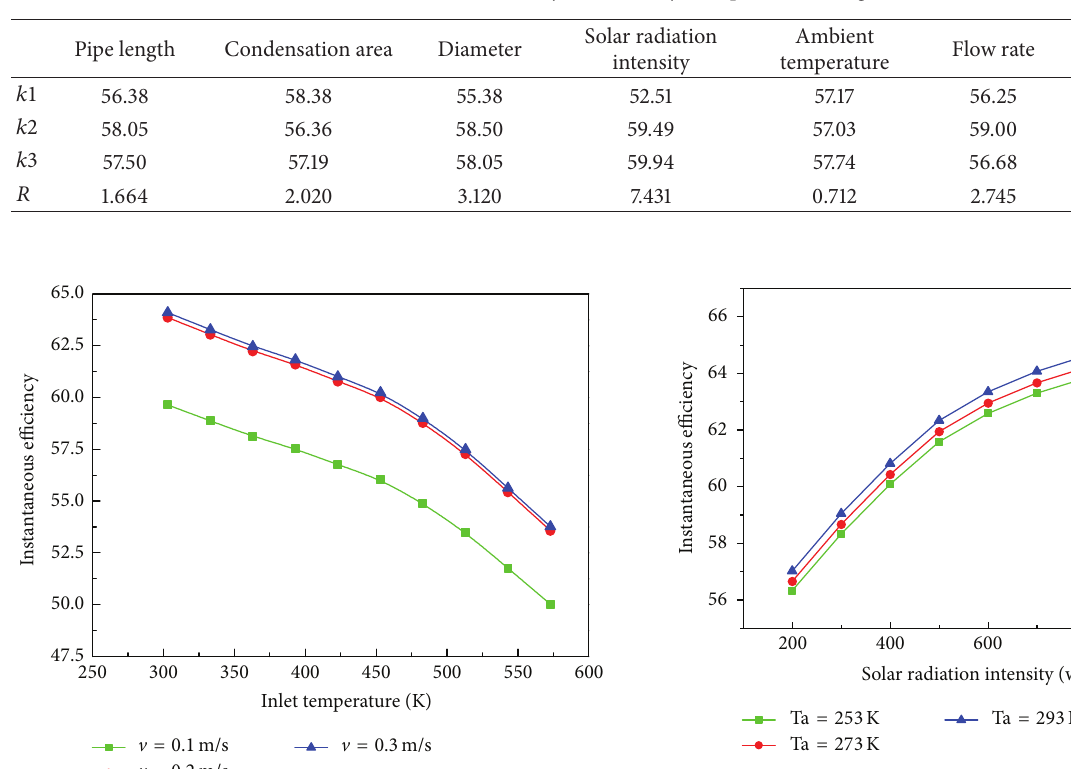
Table 5: Instantaneous efficiency factors analysis of parabolic trough collector (%).